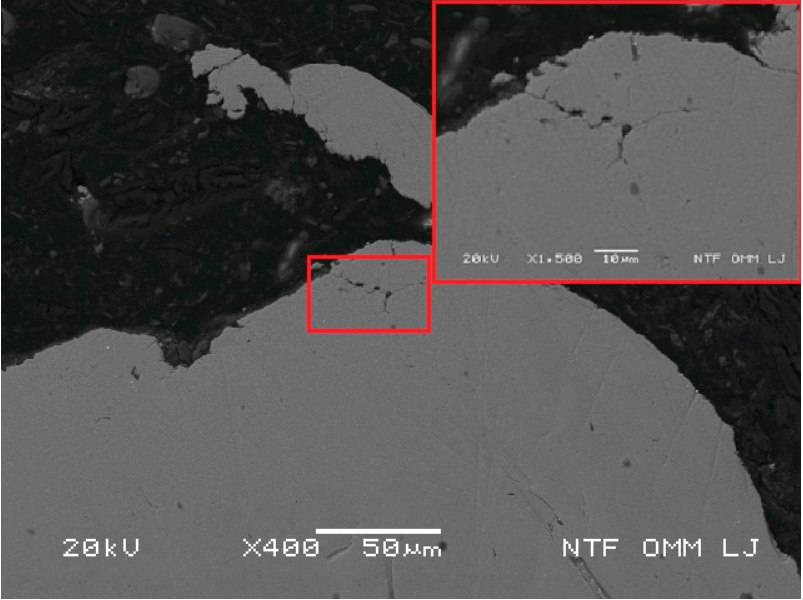
Figure 12. Micro cracks and erosion channels.